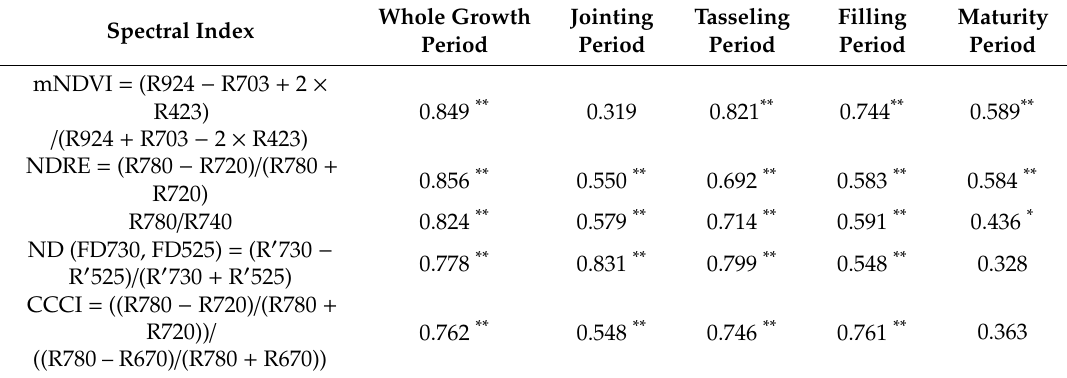
Table 7. Correlation coefficients between corn canopy nitrogen concentration and spectral indices (2017).